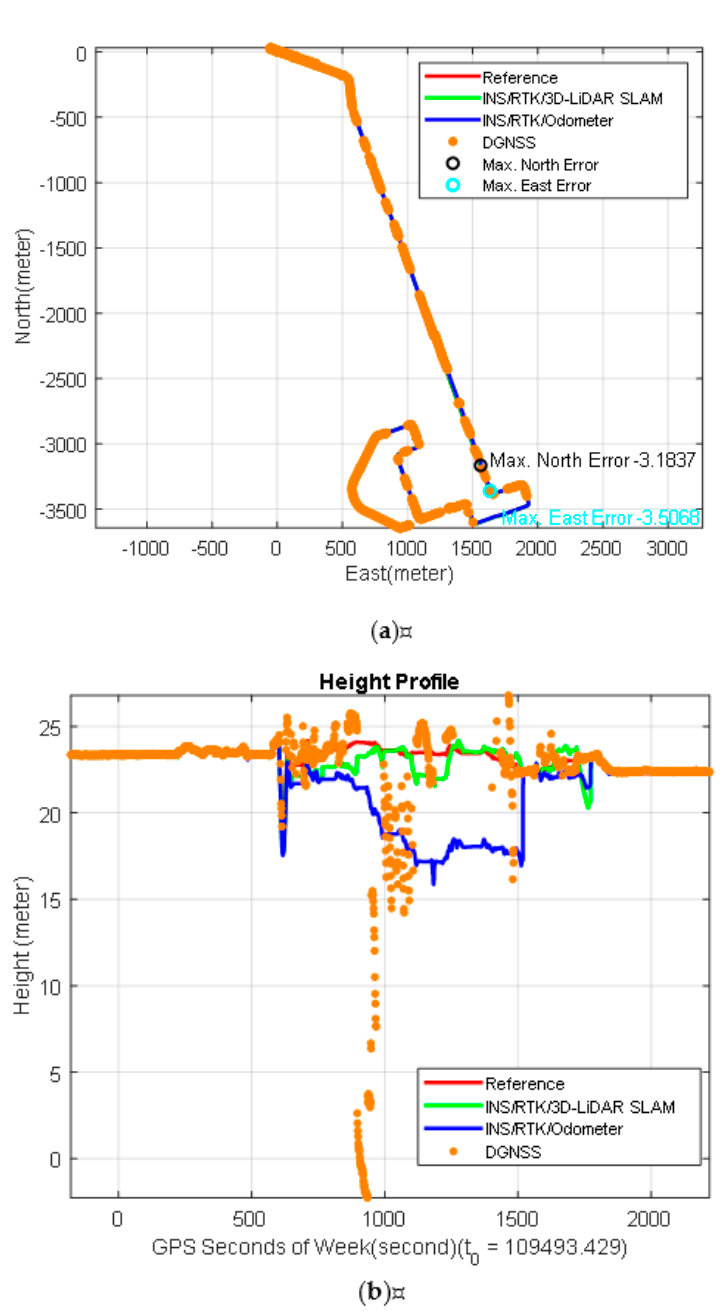
Figure 10. Scenario 1 results: ( a ) horizontal trajectory, ( b ) height